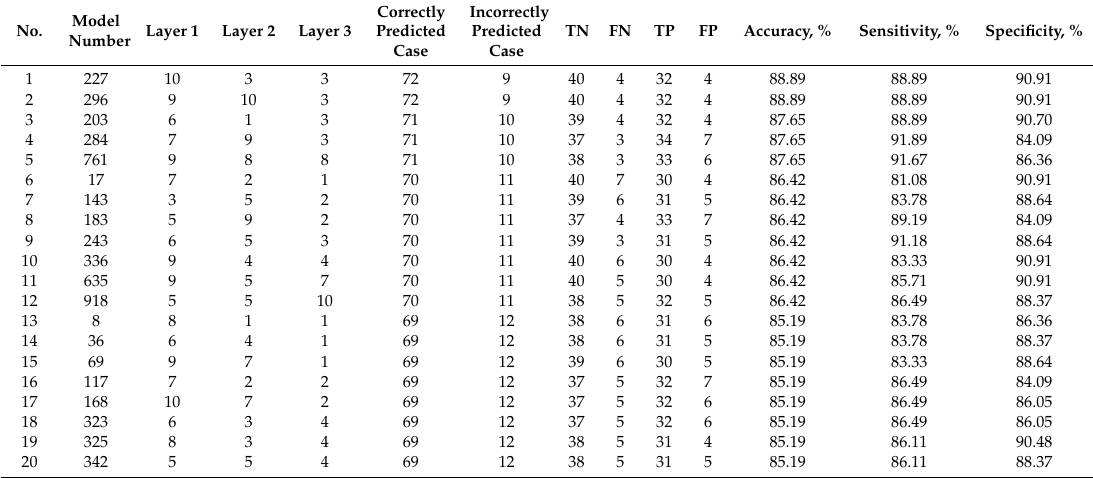
Table 12. Top twenty “Accuracy” results for the hyperbolic tangent activation function ANN models. No.